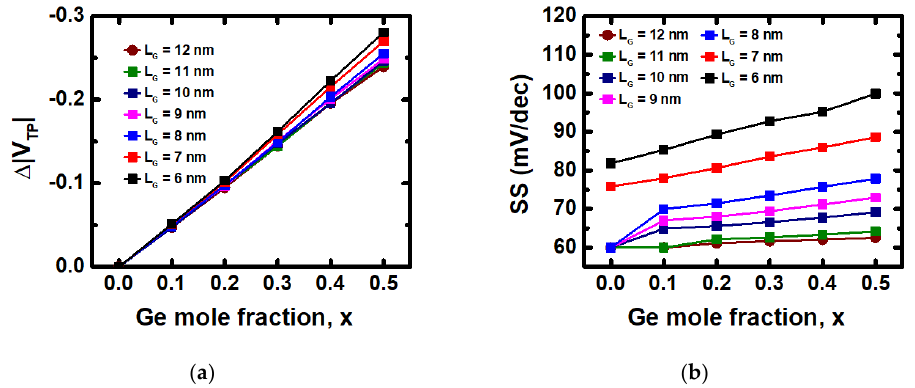
Figure 8. ( a ) V TP and ( b ) SS of Si 1-x Ge x PMOS with Ge mole fraction from 0 to 0.5, and L G from 12 nm to 6 nm.